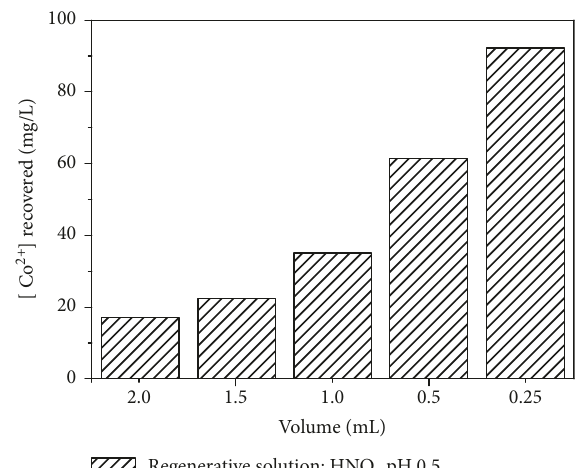
Figure 13: Results of the concentration test, decreasing the volume of regenerative solution (HNO 3 , 0.5 pH).